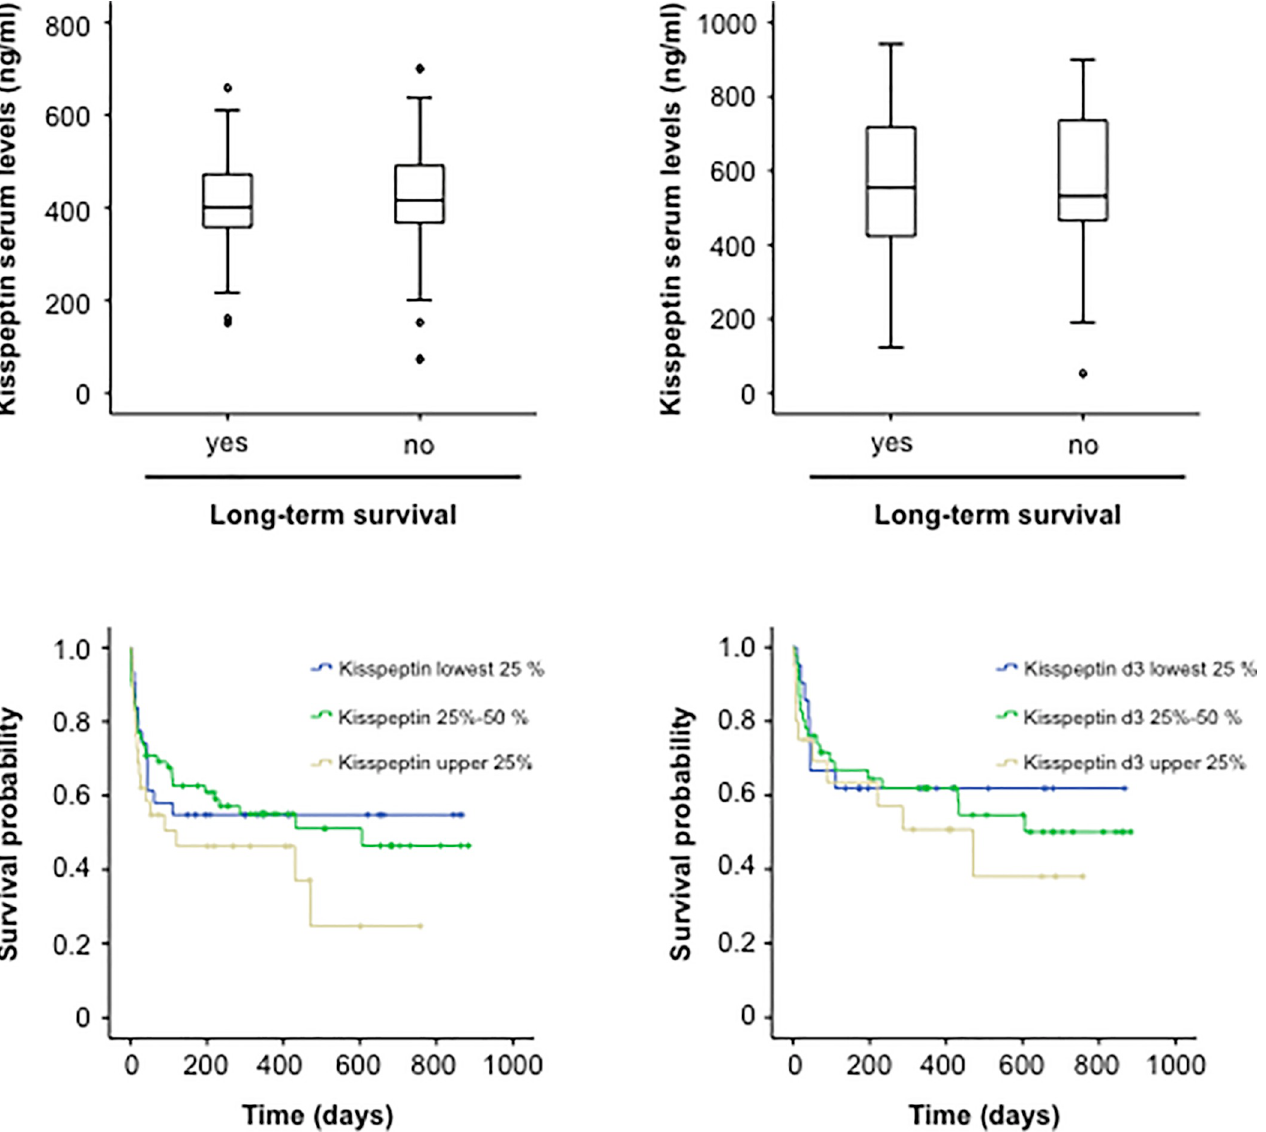
Fig 5. Elevated kisspeptin concentrations do not reflect long-term survival. (a) Serum levels of kisspeptin at admission to the ICU were similar in patients that survived in the long-term observation period and patients that succumbed to death. (b) Serum levels of kisspeptin after three days of ICU-treatment were similar in patients that survived in the long term observation period and patients that succumbed to death. (c) Kaplan-Meier curve analysis revealing that serum levels of kisspeptin at admission to the ICU did not reflect patients long-term survival. (d) Kaplan-Meier curve analysis revealing that serum levels of kisspeptin after three days of ICU treatment did not reflect patient long-term